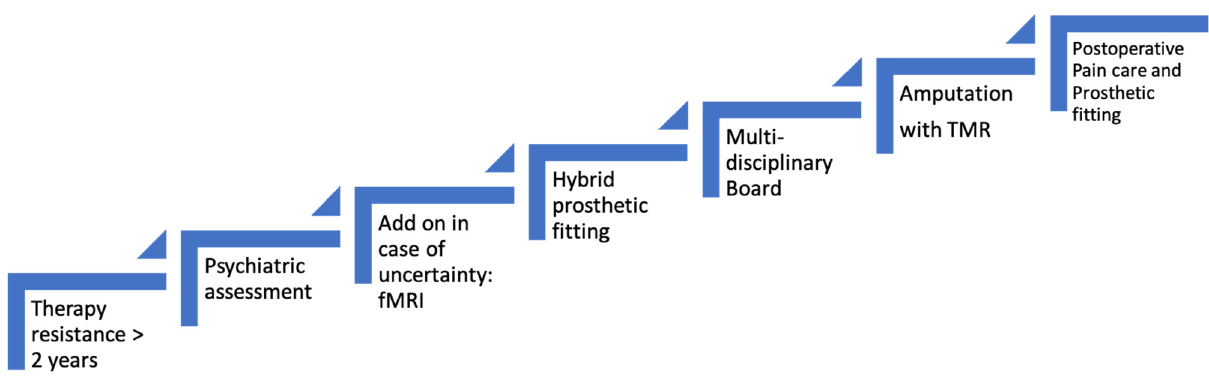
Figure 1. Algorithm for indicating amputation in CRPS